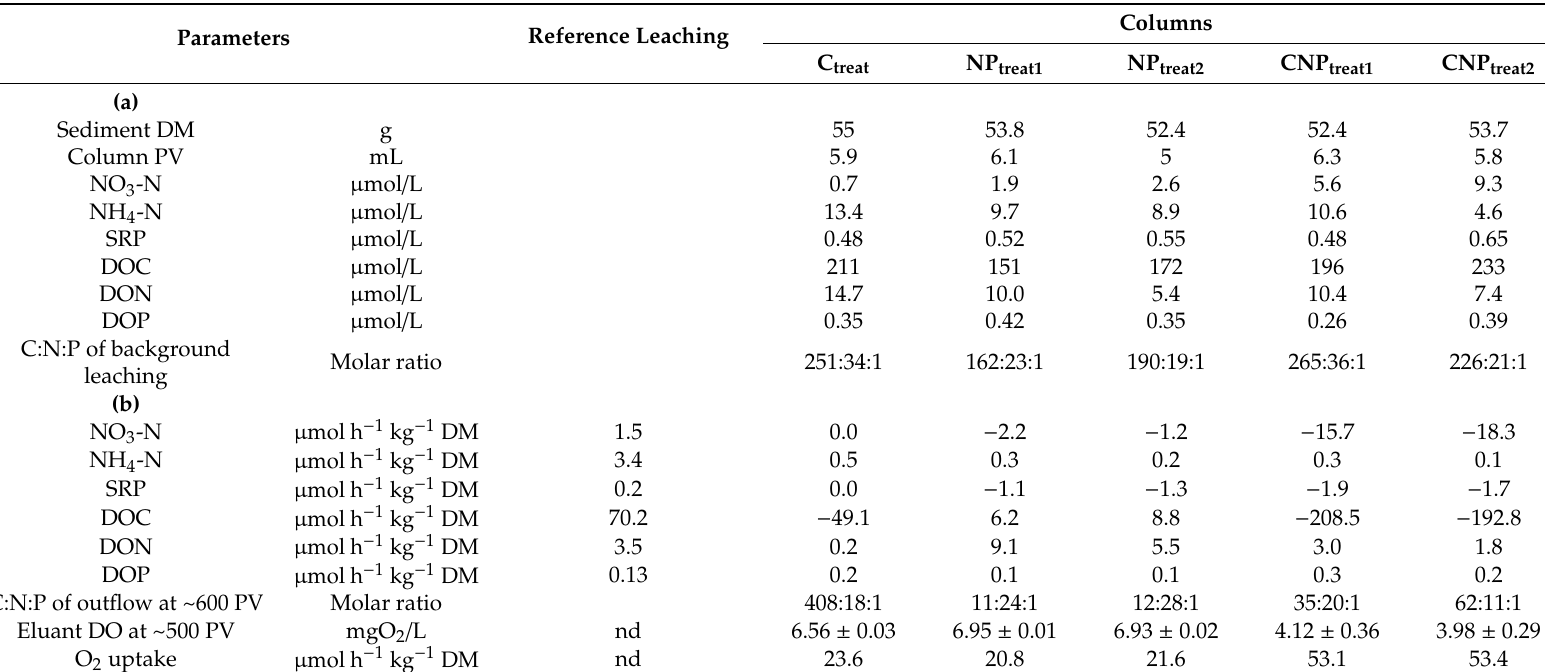
Table 1. Column physico-chemical and leaching parameters showing ( a ) the concentrations (and molar ratios) of background leaching prior to treatments, and ( b )